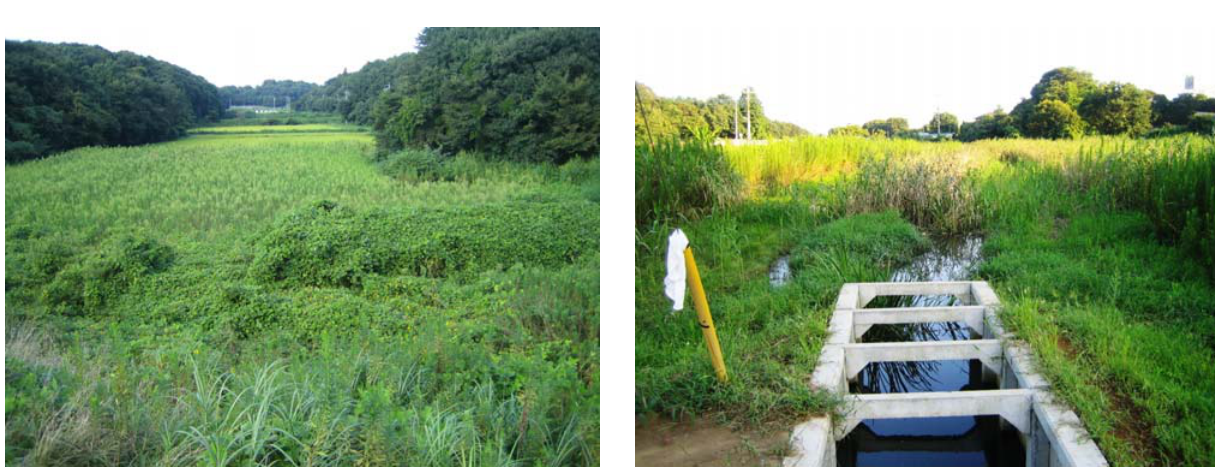
Figure 2. Typical landscape of abandoned paddy fields in yatsu valleys (30 km from central Tokyo). Abandoned paddy fields have been transformed into wetlands with discharged